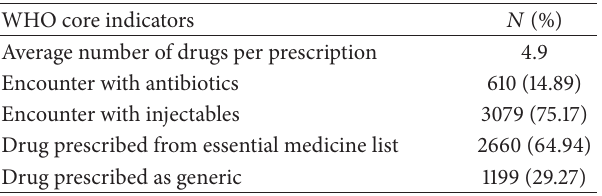
Table 4: Analysis of prescriptions using WHO core prescribing